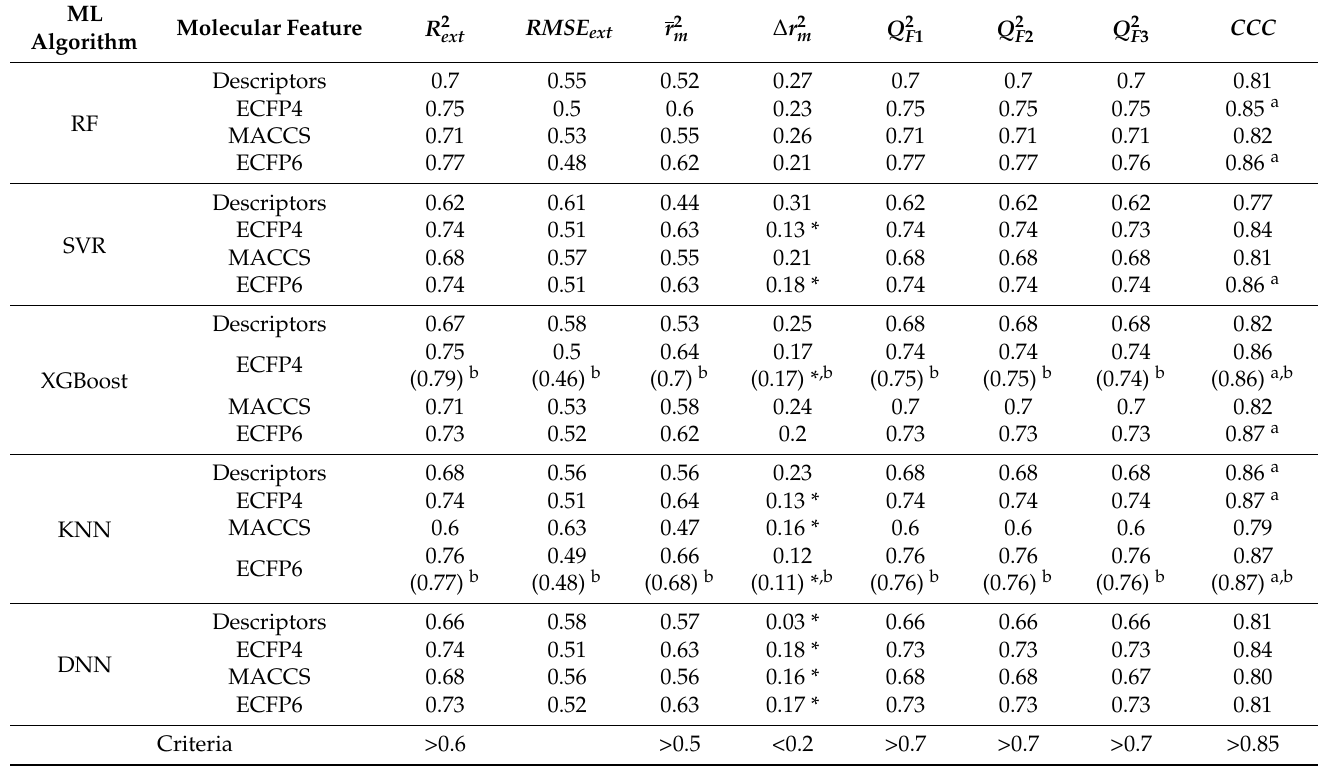
Table 2. External validation parameters of regression QSAR